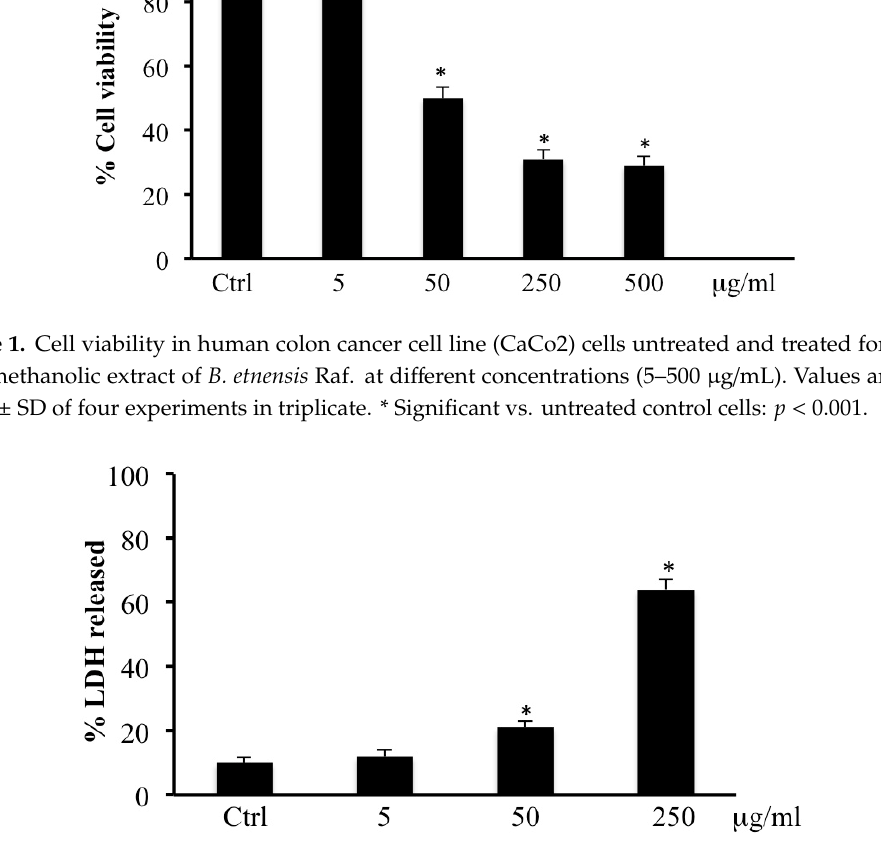
Figure 2. Lactic dehydrogenase (LDH) released in CaCo2 cells untreated and treated for 72 h with methanolic extract of B. etnensis. Raf. at different concentrations (5–250 µg/mL). Values are the mean ± SD of four experiments in triplicate. *Significant vs. untreated control cells: p < 0.001.